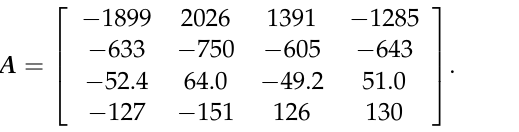
Figure 9. ( a ) Output voltage when a z -directional force is applied to A6. ( b ) Output voltage when a y -directional force is applied.